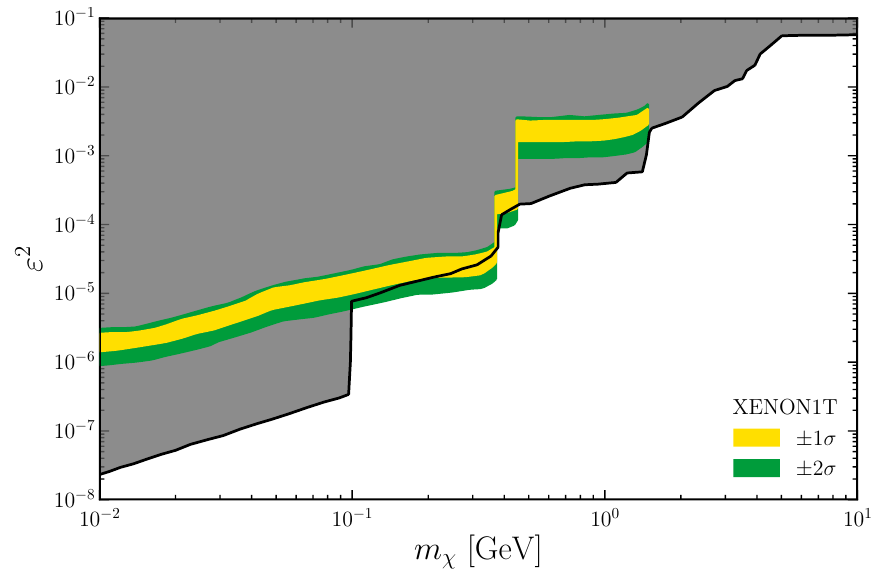
Figure 11 . Preferred parameter space from XENON1T. Yellow/green bands depict the ± 1 σ / ± 2 σ preferred parameter space of our XENON1T analysis when we assume that the B 0 background of ref. [86] accurately represents all backgrounds. All existing constraints are shown in